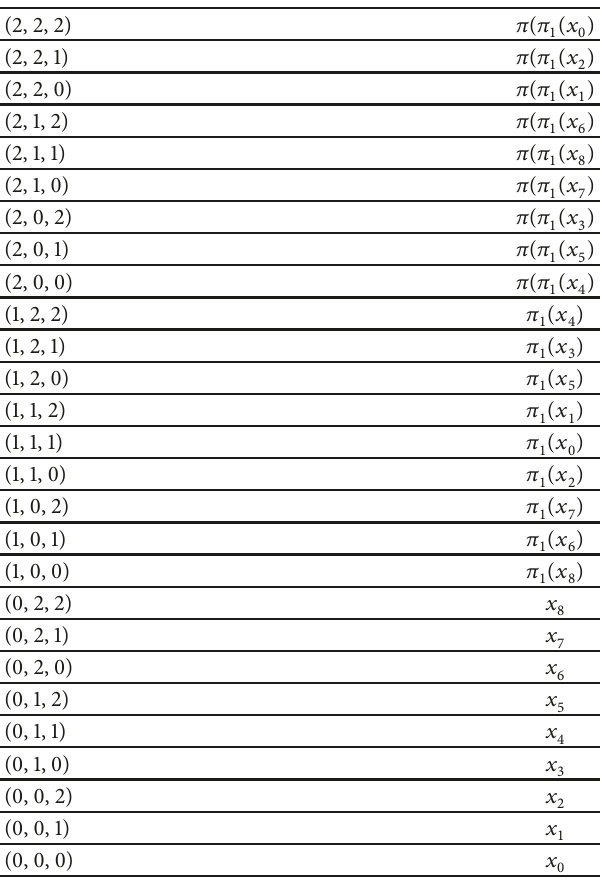
Table 2: Rule table for the template representative of CAs invariant to 𝜋 1